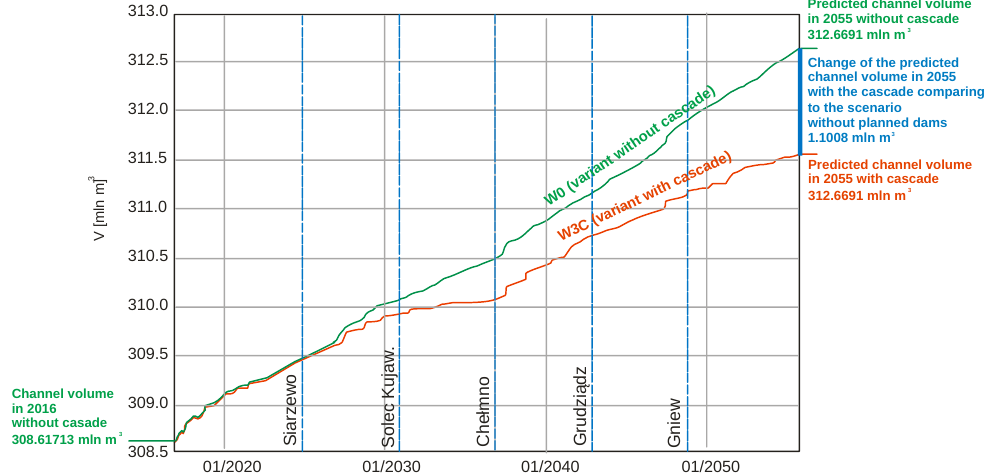
Figure 9. The effect of the planned cascade of the Lower Vistula River on the volume of the river